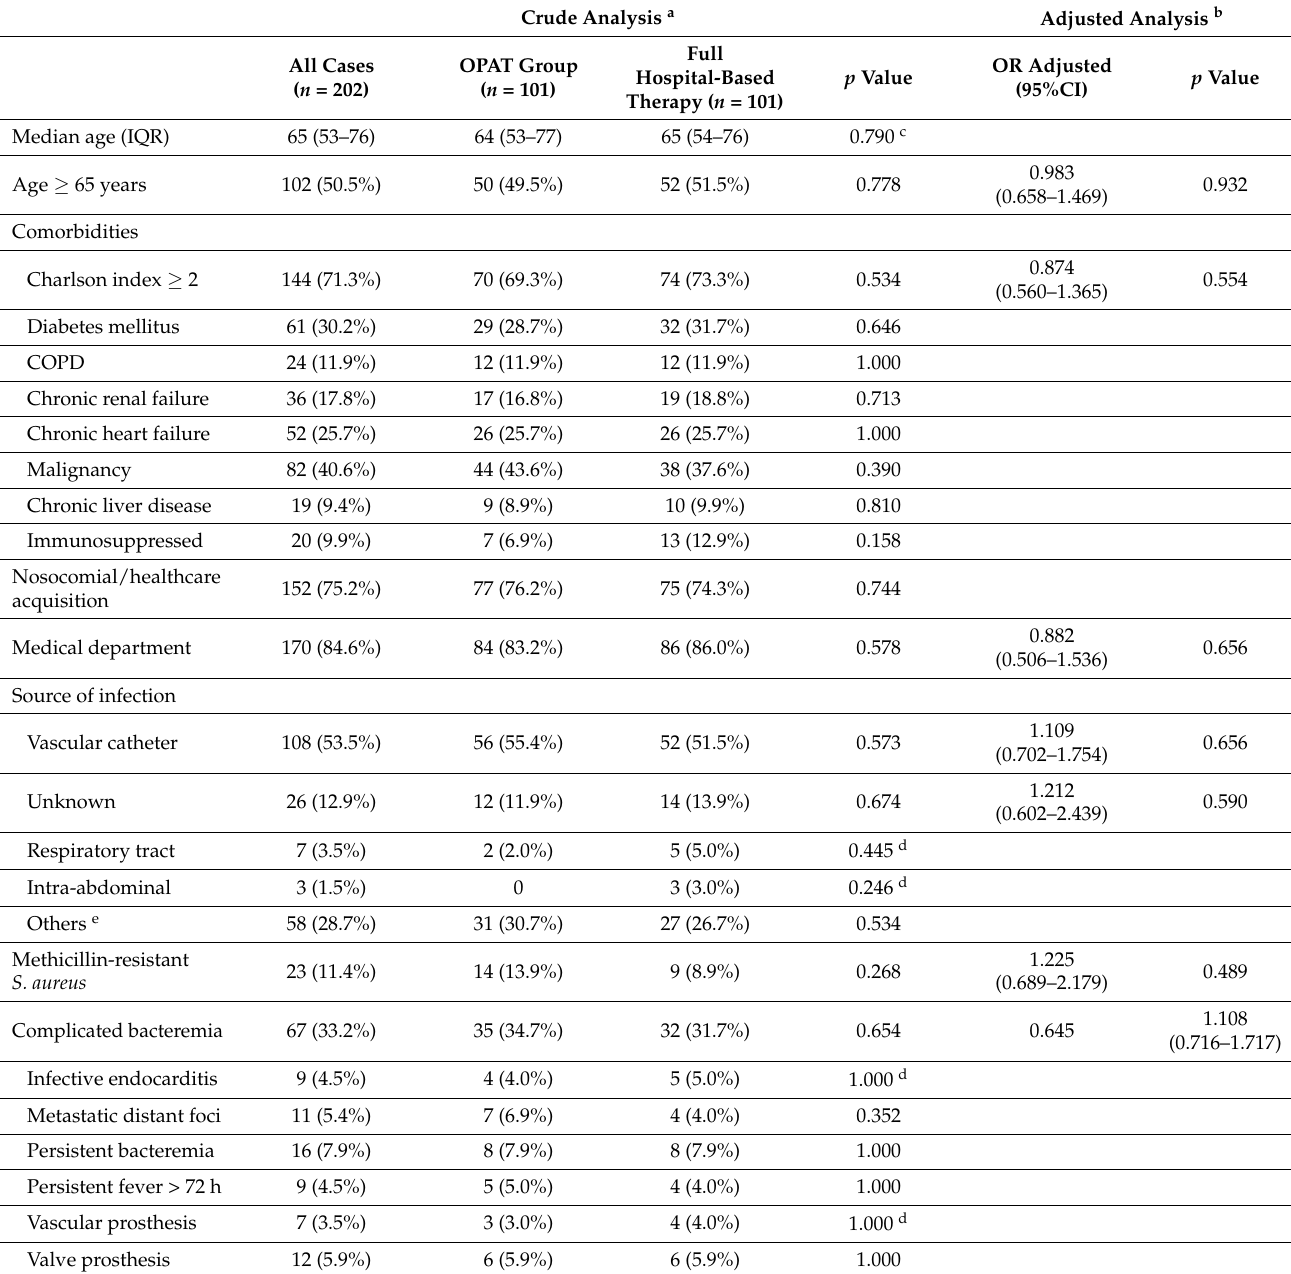
Table 4. Crude and multivariate analysis of matched cases according to propensity